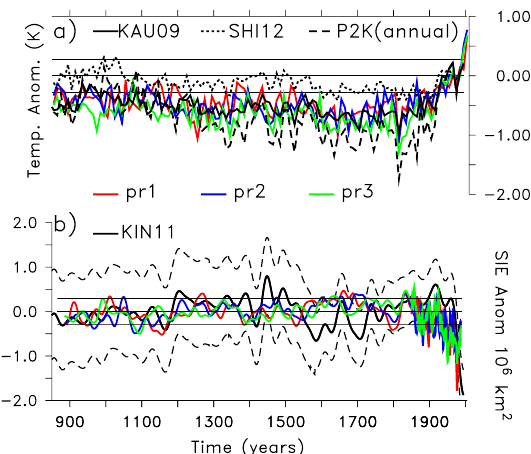
Figure 1. Simulated time series (coloured lines for experiments pr1, pr2, pr3) of high-northern-latitude climate variables in comparison with reconstructions (black lines): (a) 10-year averages of Arctic summer (JJA) surface air temperatures as anomalies w.r.t. the 1960– 1990 mean. Summer temperature reconstructions are from (solid black) Kaufman et al. (2009) and (dotted black) Shi et al. (2012). The PAGES2K reconstruction representing annual temperatures is also shown (dashed black). (b) Late-summer (August) sea-ice ex- tent (in 10 6 km 2 ) as anomalies w.r.t. the pre-industrial mean in com- parison with the reconstruction by Kinnard et al. (2011): the thick black line denotes the 40-year smoothed reconstruction, the dashed black lines their 95% confidence interval; for the simulations, a 41- year running mean was applied for pre-industrial millennium and a 5-year running mean for 1850–2005 to better display 20th-century variability. Thin horizontal lines bracketing the zero line in (a) and (b) indicate the respective 2 σ ranges derived from the 1000-year- long PiCtrl